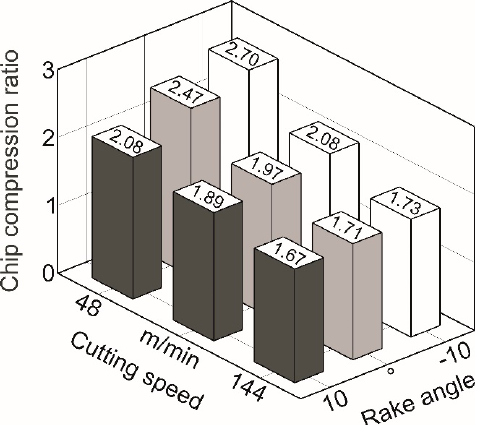
Figure 5. Plot of chip compression ratio for different rake angles and cutting speeds in the machining of AISI 1045 steel.